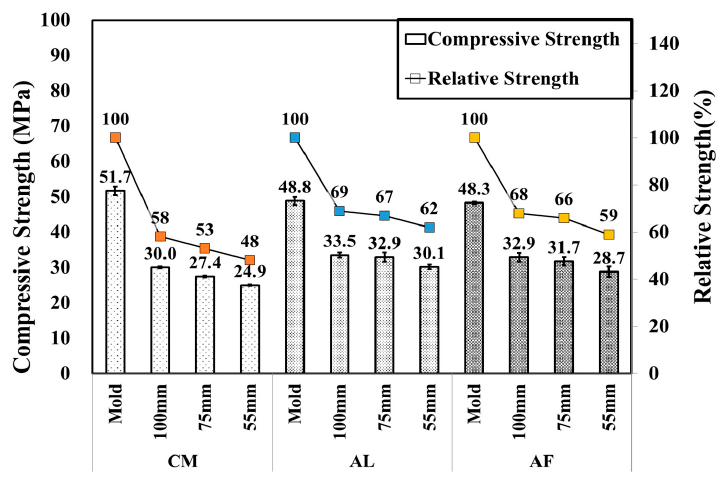
Figure 3. Core compressive and relative strengths of CO and SH specimens by accelerators for 1 month-old specimens.